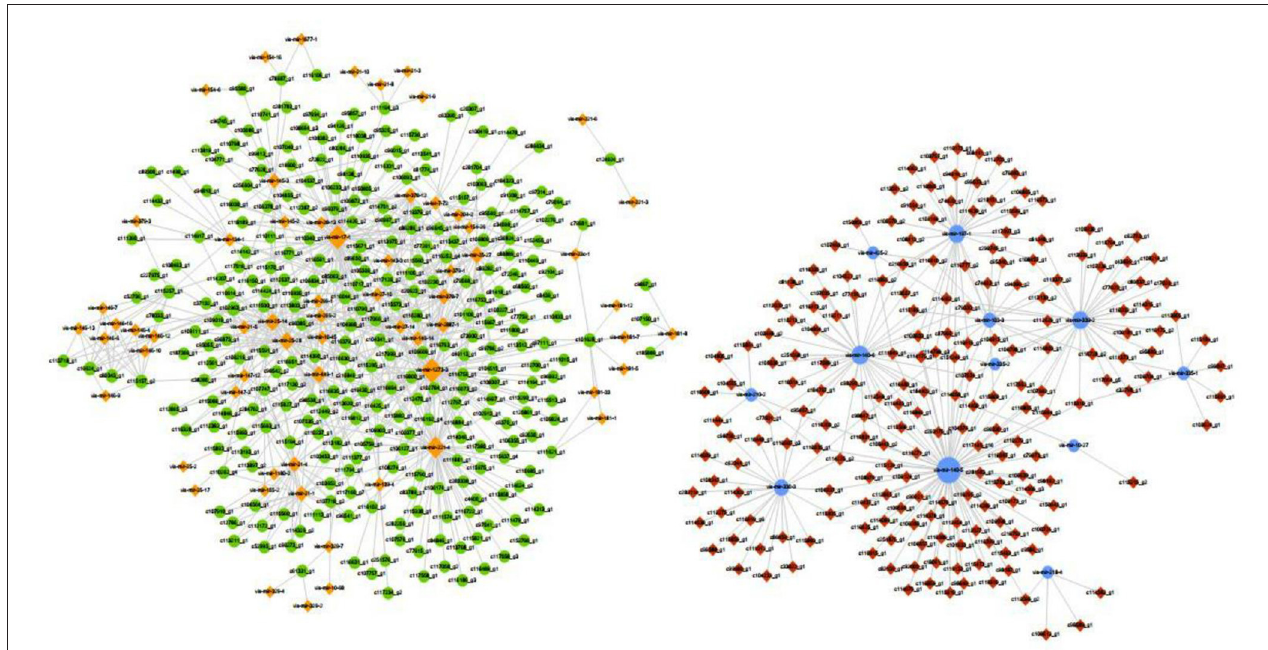
FIGURE 5 | miRNA-mRNA interaction network. The blue circle represents miRNA downregulation, and yellow diamond represents miRNA upregulation. The red diamond represent target mRNA gene upregulation and green circle represent target mRNA gene